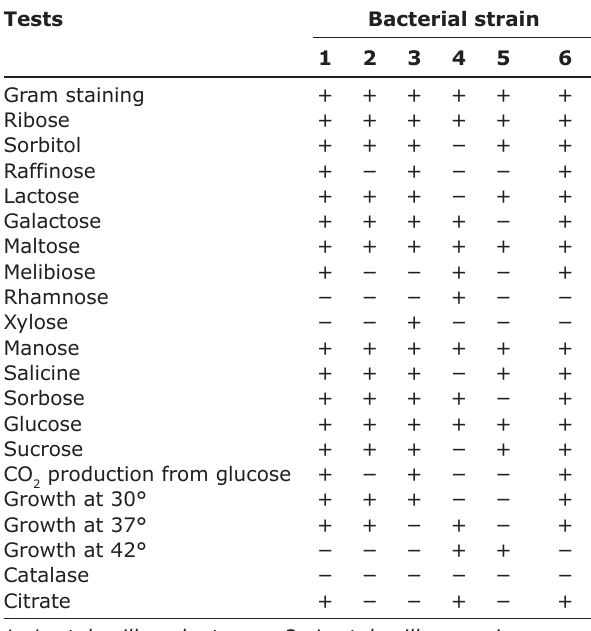
Table-1: Results of Gram staining and biochemical tests of Lactobacillus